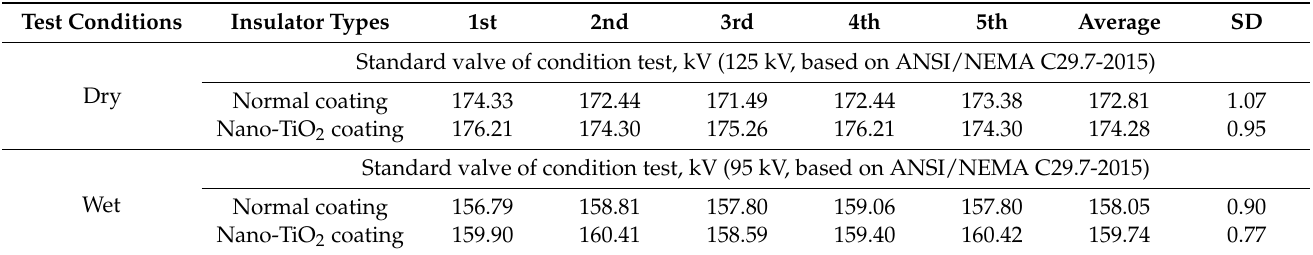
Table 2. Test results of low-frequency flashover performances under dry and wet test condition